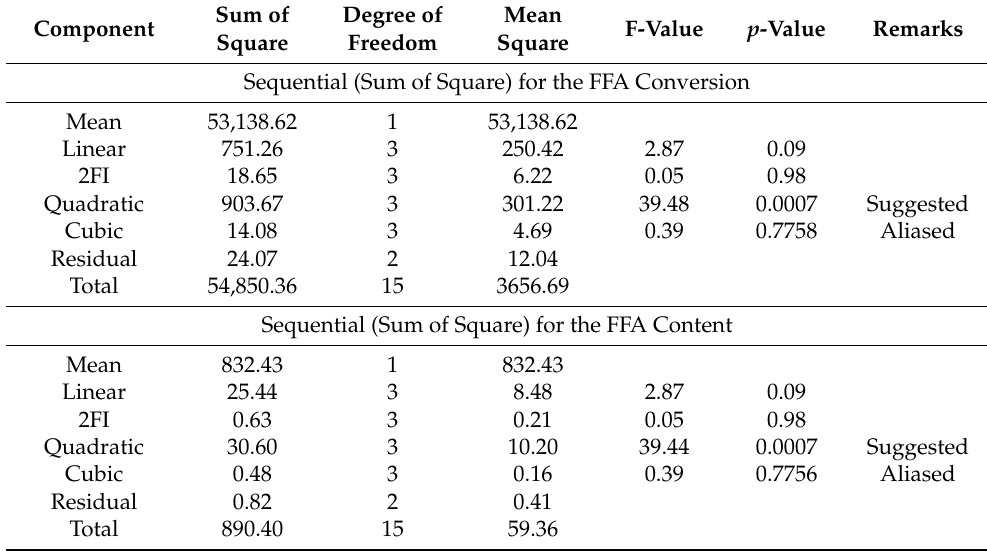
Table 4. Sequential Model (Sum of Squares) Test.